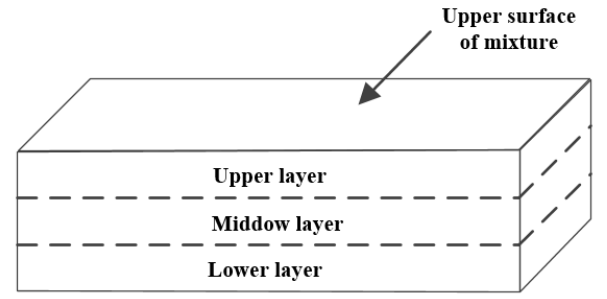
Figure 9. The schematic diagram of the division of the specimen.